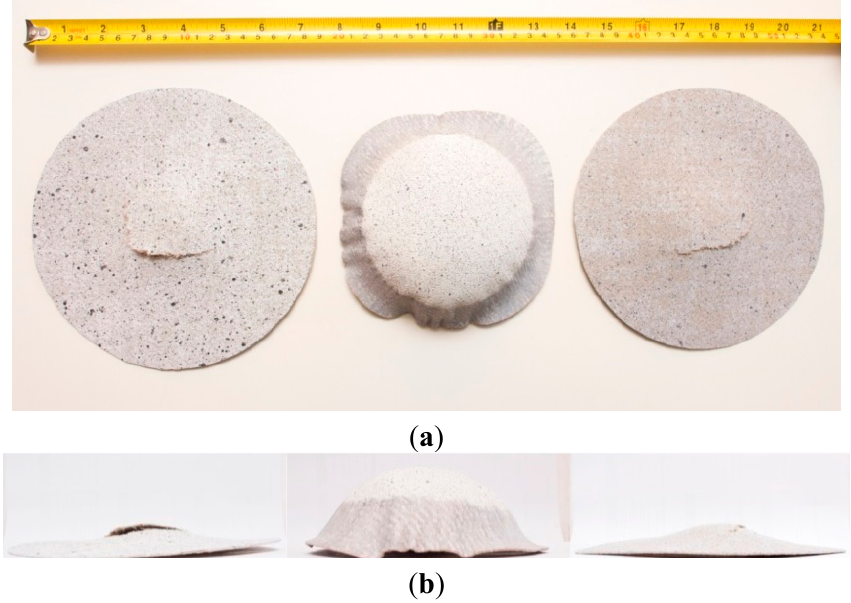
Figure 8. Images of the untreated, saturated and dried NFC (from left to right) after stamp forming experiments from, ( a ) top view; and ( b ) front